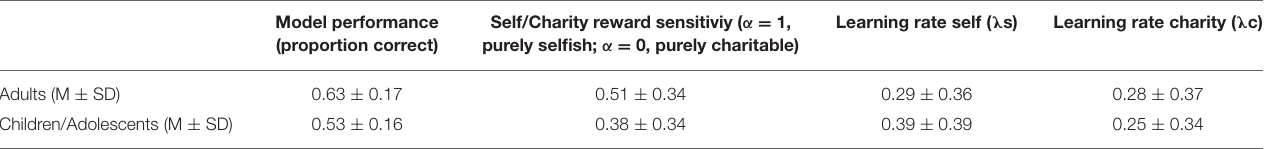
TABLE 2 | Model parameters in the two age groups.